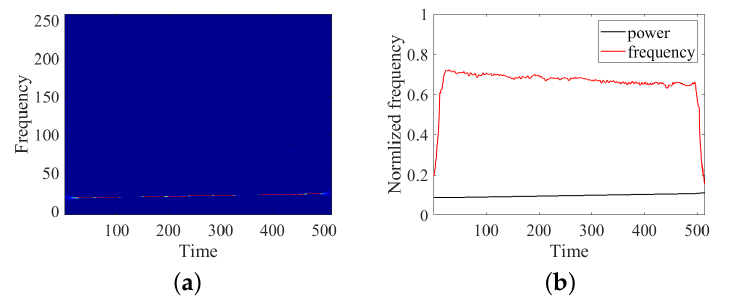
Figure 9. The SST feature of a sample in DatasetII. ( a ) VSST. ( b ) Feature